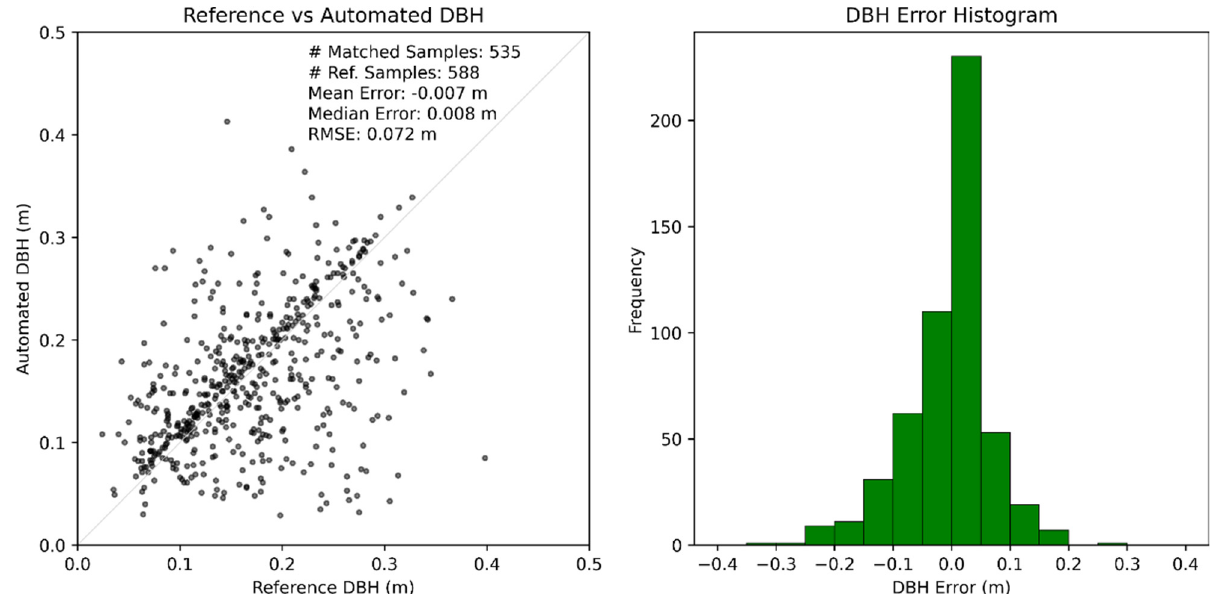
Figure 11. Left shows a scatter plot of the automatically measured DBH compared with the reference tree DBH. The grey line shows what a perfect result would be (y = x). Right shows the distribution of the DBH errors.